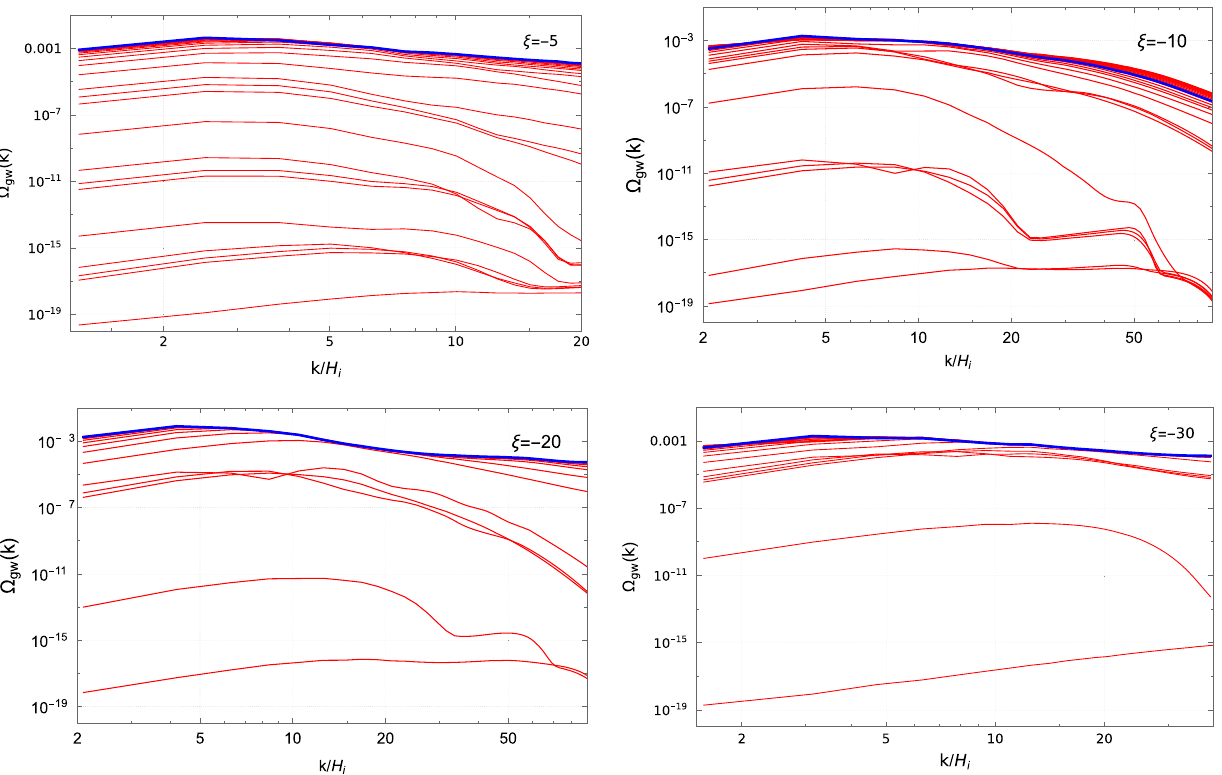
Fig. 3 The evolutions of the density spectra of GWs as a function of k / H i with time t for ξ < 0. The spectra from bottom to up are plotted with the time interval (cid:14) t = 0 . 0625 H − 1 , with Blue line corresponding to the final result i